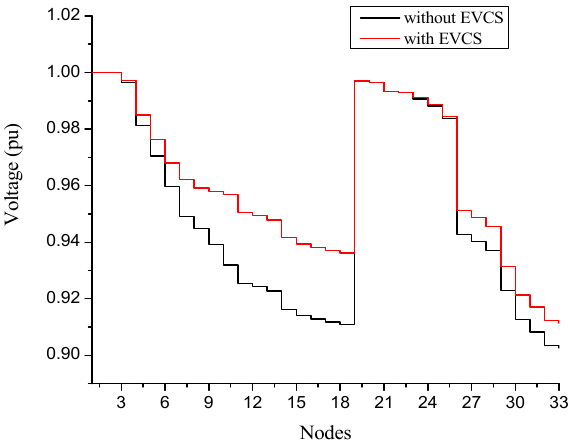
Figure 7. Voltage profile with and without EVCS. EVCS was integrated at node 9 using a genetic algorithm with the capacity of 663.9 kVA and the active power losses of 160.62 kW, as shown in Figure 8.